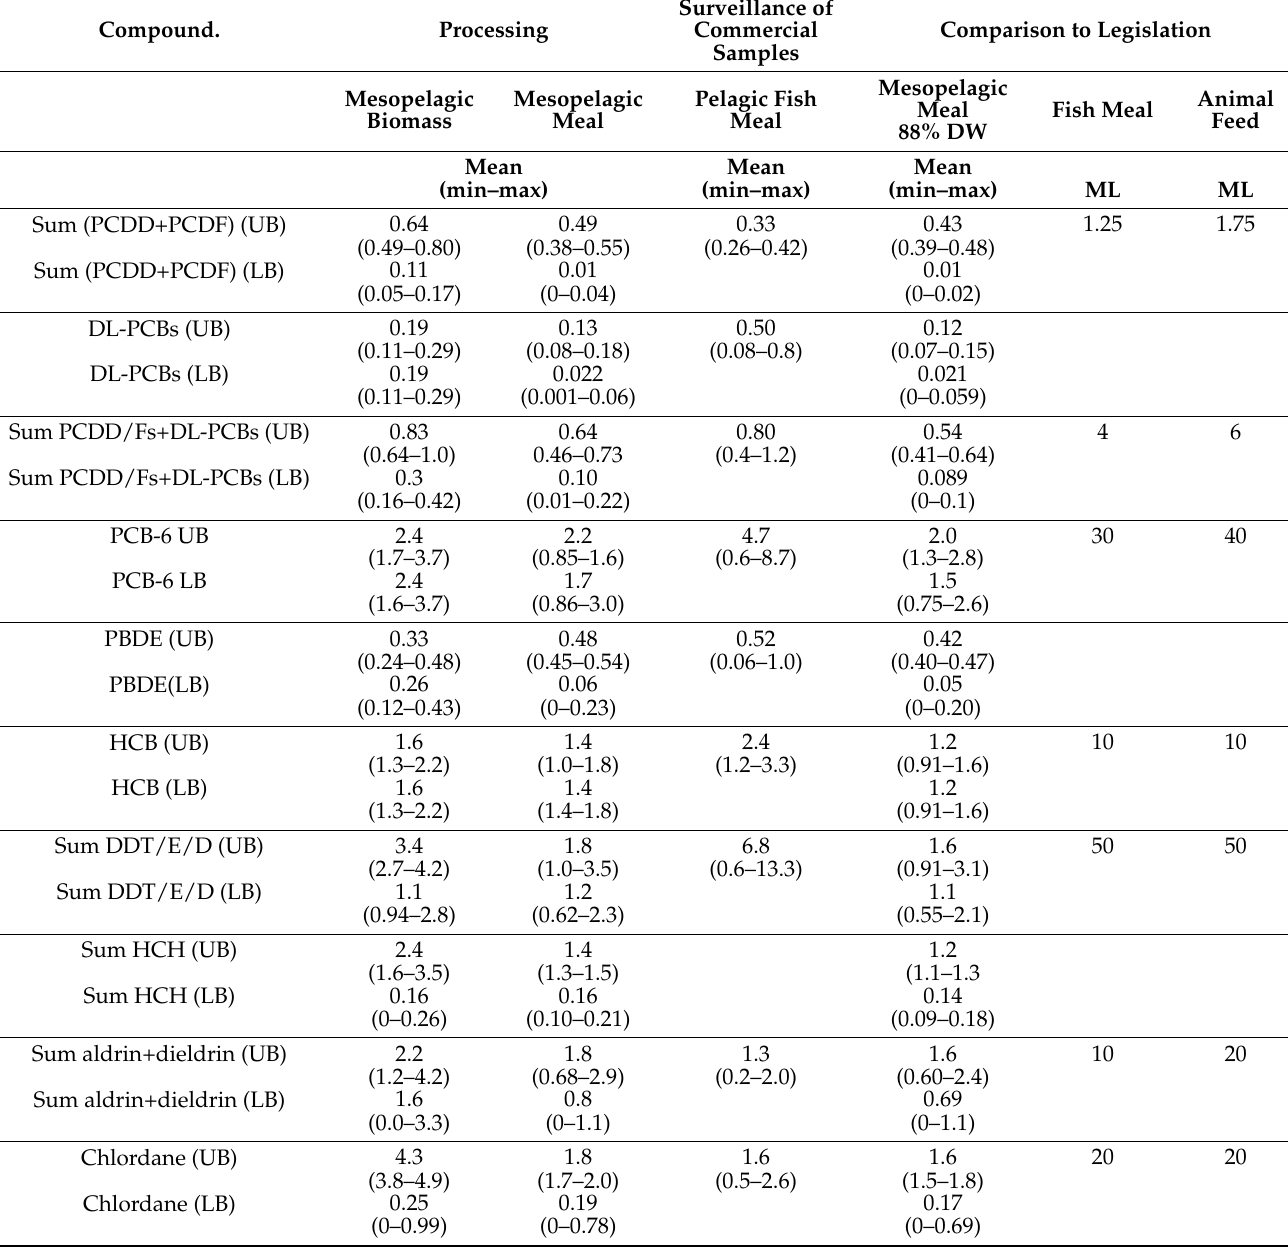
Table 4. Concentrations of dioxins (PCDD/F), dioxin-like PCBs (DL-PCBs) (WHO-TEQ pg g − 1 per DW), polybrominated diphenyl ether mixtures (PBDEs) and organochlorine pesticides (ng g − 1 per DW) (mean, minimum-maximum, n = 4) in the raw mesopelagic biomass, the concentration in processed mesopelagic meal (DW), surveyed commercial pelagic fish meals (n = 9), and mesopelagic meal expressed as 88% DW. Concentrations are expressed as upper-bound (UB) with none detected congeners expressed as limit of quantification or lower-bound (LB) with undetected congeners expressed as zero. For comparison, the maximum limit (ML) based on upper-bound concentrations, given in EU Directive 2002/32/EC are shown.